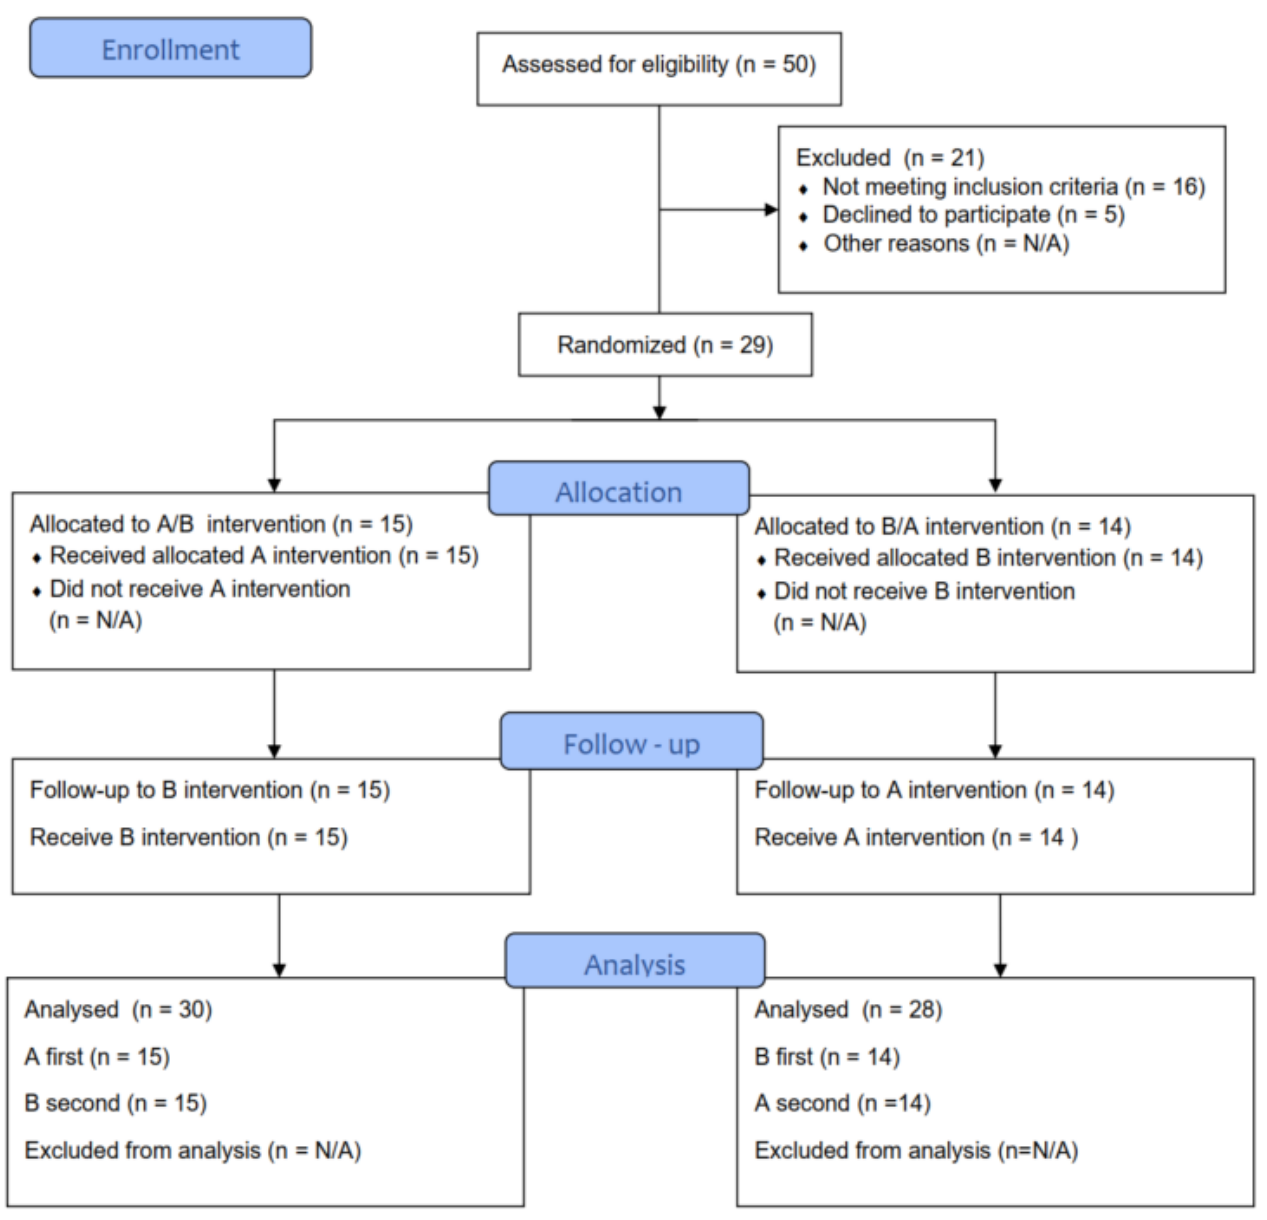
Figure 4. Consort flow diagram of randomized parallel crossover design.